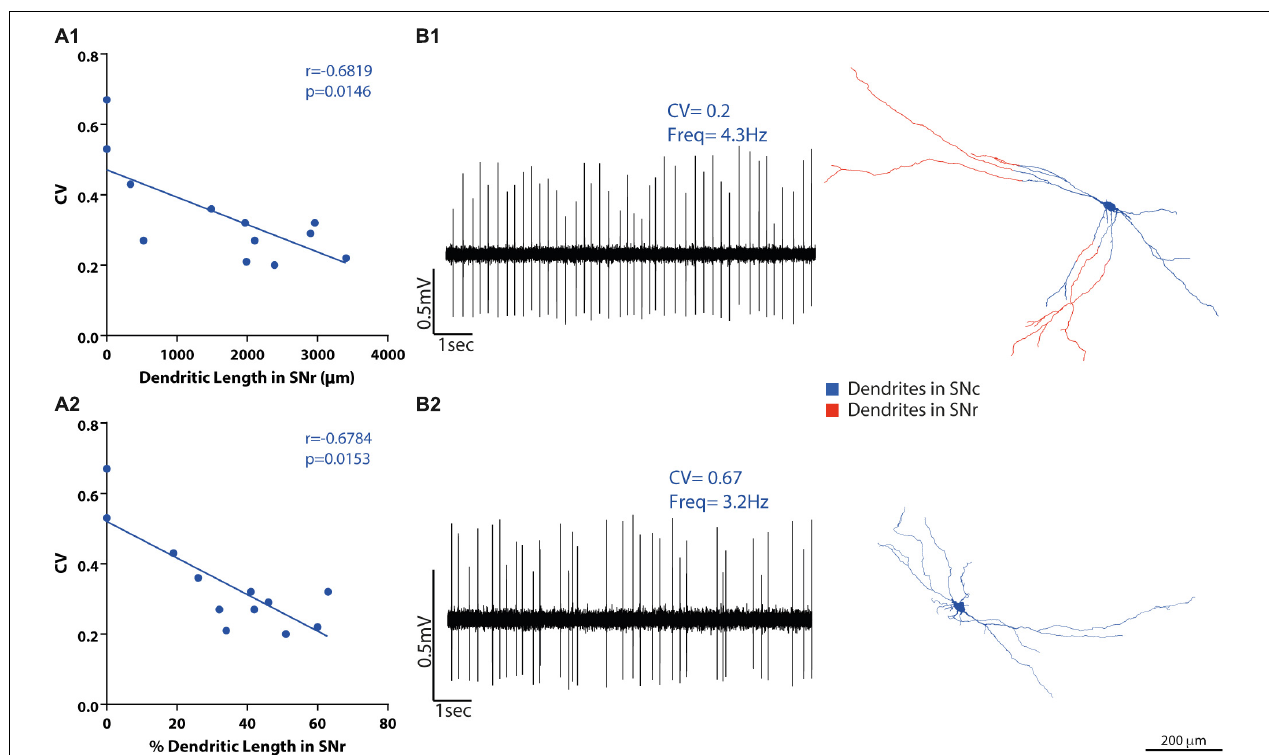
FIGURE 6 | SNc DA neuron heterotopic distribution of dendrites correlates with the electrophysiological activity of the neurons. (A1-2) Firing regularity (coefficient of variation, CV) correlations with the proportion of dendritic length in panel (A1) SNr, but not in panel (A2) SNc. (B1-2) Raw data examples of firing traces of SNc DA neurons and their matching 3D reconstructions. Examples of one [ (B1) -top] regular and one [ (B2) -bottom] irregular SNc raw baseline recordings (10 s) with their respective dendritic reconstructions [ (B1,B2) , right] showing dendrites inside SNr in red and their dendrites inside SNc (and other subdivisions, not shown) in blue. Scale bar = 200 µ